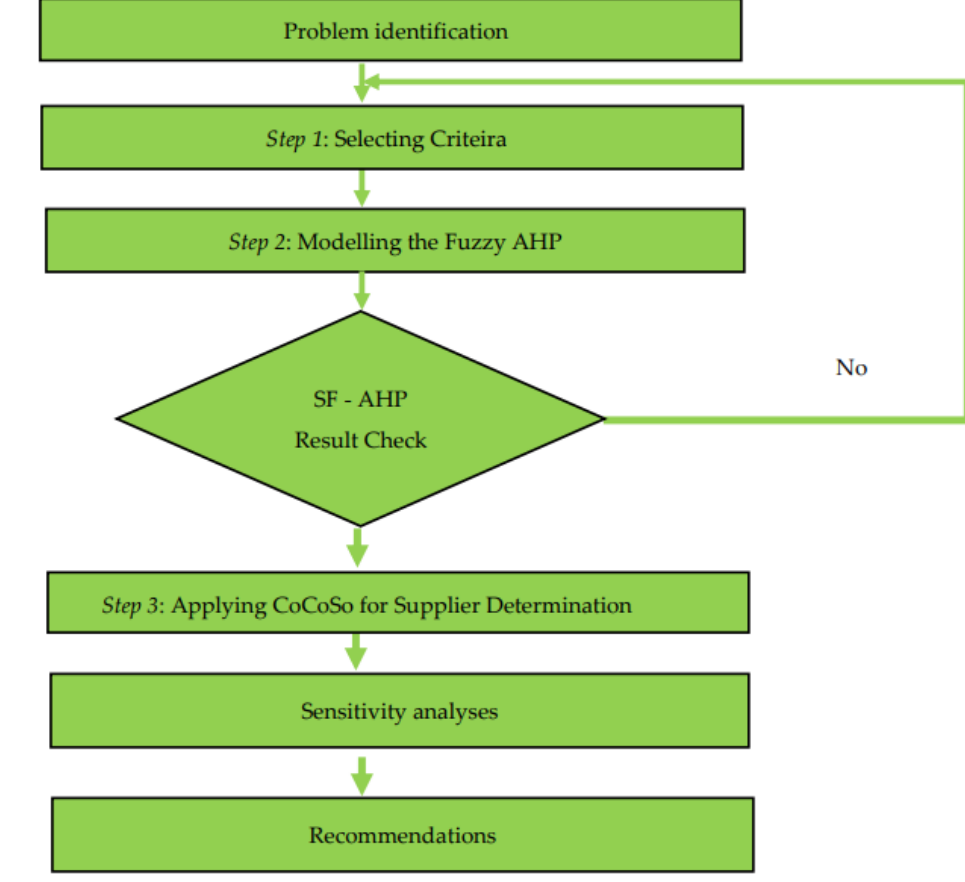
Figure 2. Research process.